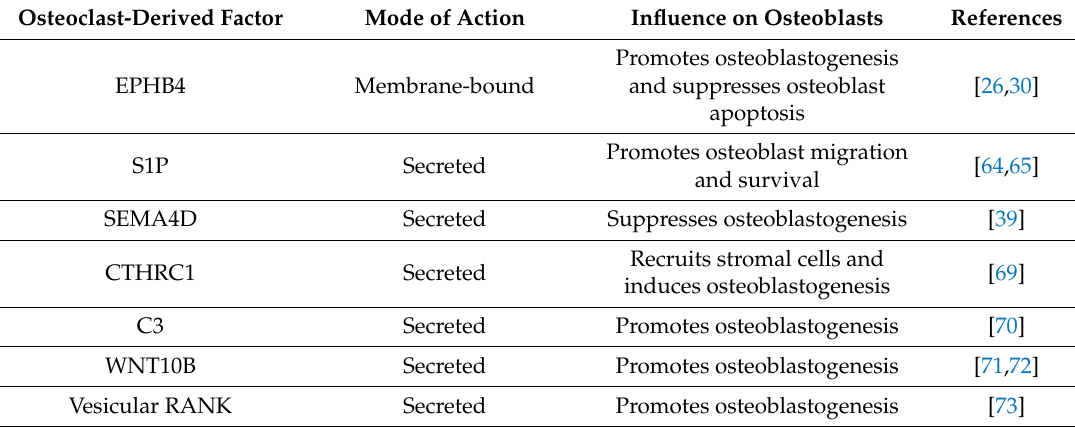
Table 2. Summary of e ff ects of osteoclast-derived factors on